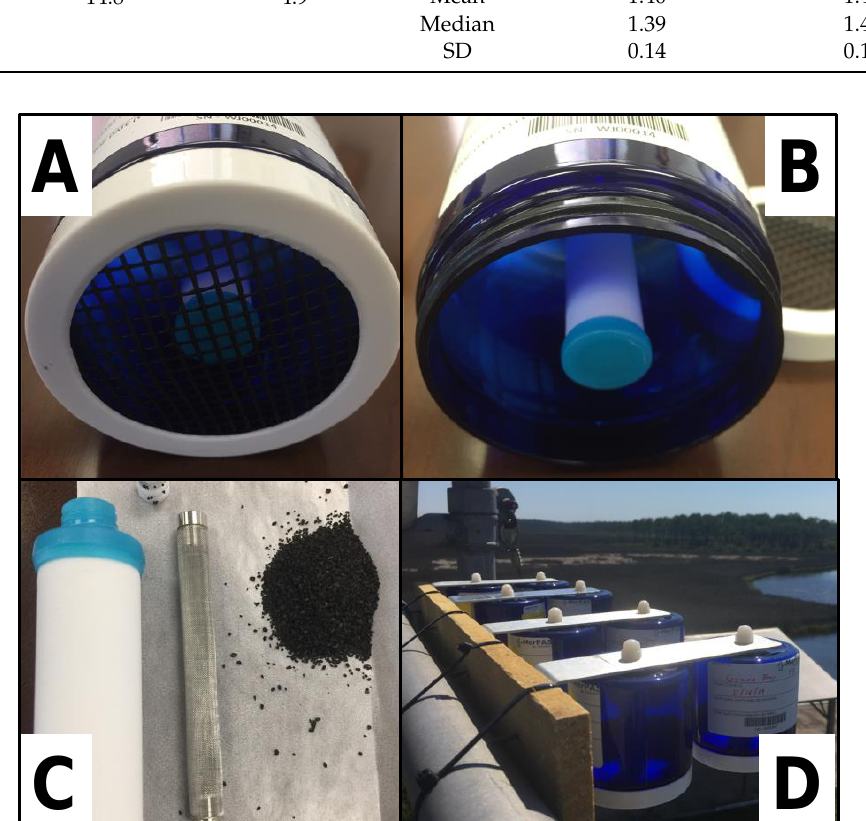
Figure A1. Photos showing the MerPAS ® configuration with cover on ( A ), with the cover off ( B ), and with diffusive body, stainless steel screen, and activated carbon sorbent removed ( C ), and deployment on the tower at Grand Bay ( D ).